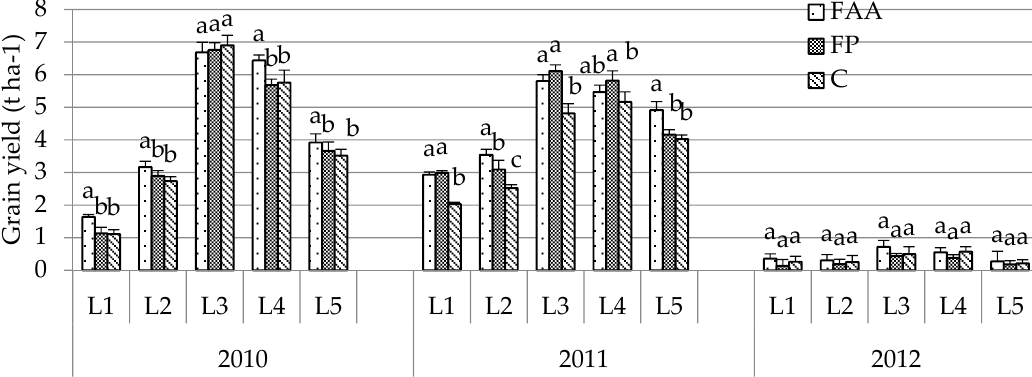
Figure 2. Effects of applied fertilizers on maize grain yield (t ha − 1 ). L1–L5—maize lines. FA—amino acid foliar fertilizer, FP—phosphate foliar fertilizer, C—control. L1—FAO 200; L2—FAO 300; L3—FAO 500; L4—FAO 600; L5—FAO 600. Averages followed by the same letter do not differ by LSD test at α = 0.05.